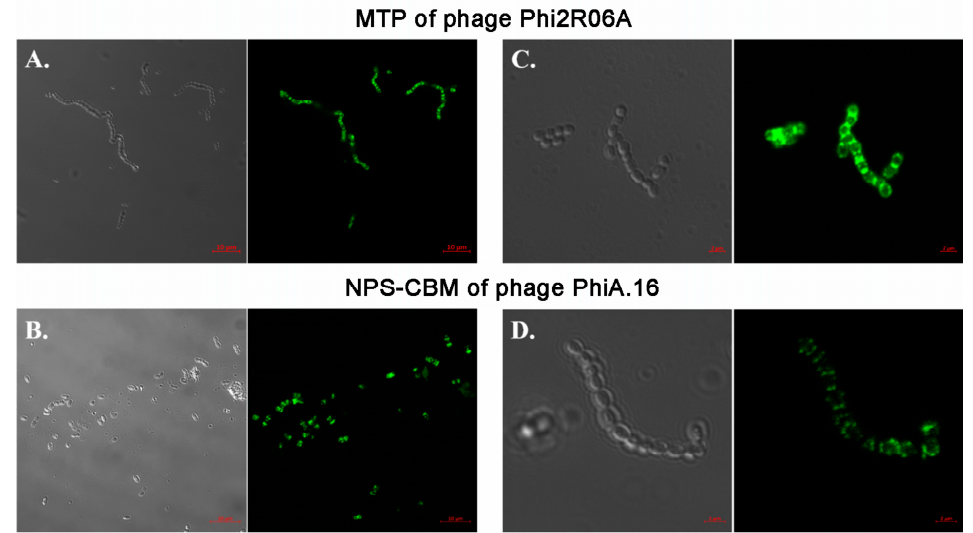
Figure 5. Binding assays of GFP-labelled MTP of Phi2R06A ( A + C ) and NPS-CBM of PhiA.16 ( B + D ). ( A ) Binding of GFP-labelled TpeX of the MTP of Phi2R06A to host strain L. lactis 2. Protein was added at a quantity of 25 µ g. ( B ) Binding of the GFP-labelled NPS CBM domain of PhiA.16 to host strain L. lactis A. Protein was added at a quantity of 100 µ g. ( C ) Binding of the GFP-labelled TpeX of the